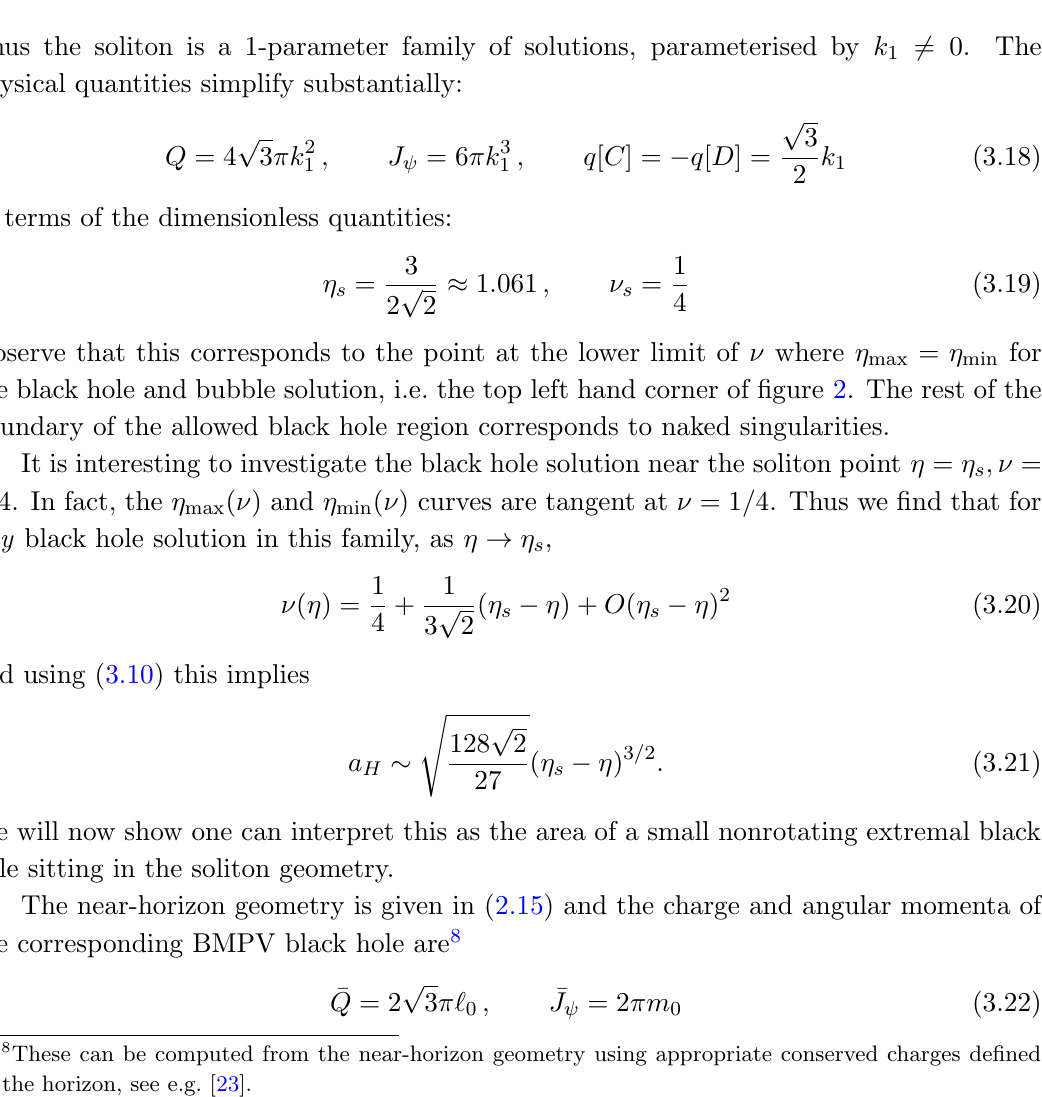
Figure 2 . (cid:17) max (blue) and (cid:17) min (yellow) versus (cid:23) for 1 = 4 < (cid:23) < 1 = (2 that bounded by the blue and yellow curves. Note that (cid:17) max > 1 for all (cid:23) . It can been seen that the allowed set of solutions exist on either side of the BMPV bound (cid:17) =